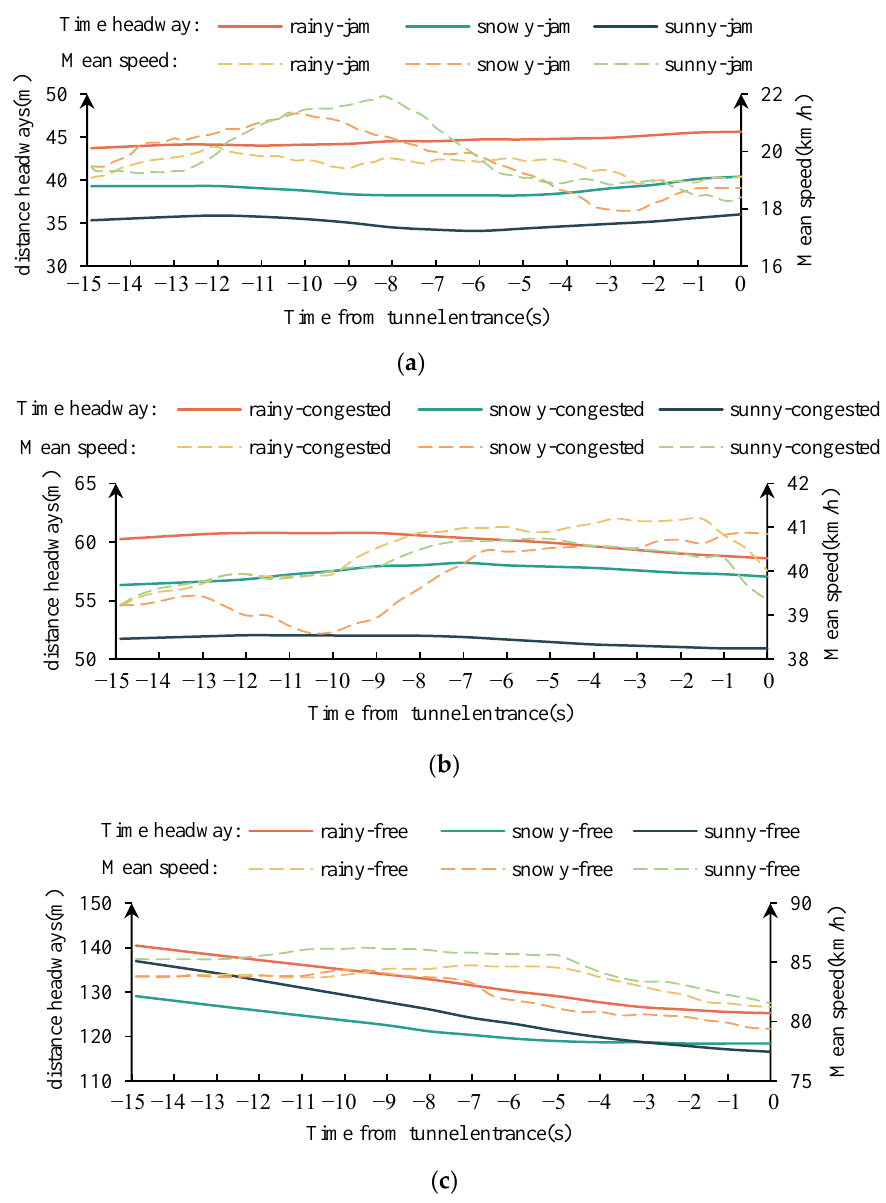
Figure 6. The average change of the distance headways within 15 s from the tunnel entrance. ( a ) jam flow condition. ( b ) congested flow condition. ( c ) free flow condition.